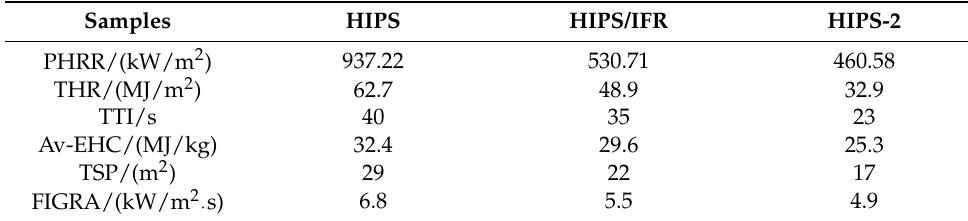
Table 3. The cone calorimetry test data of the HIPS